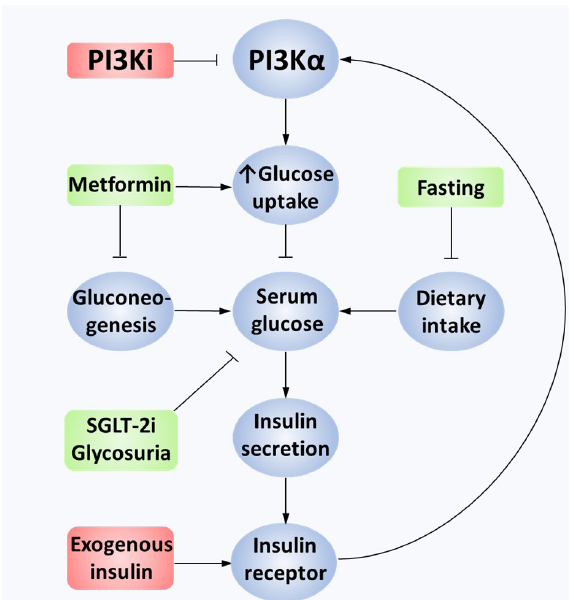
Figure 2. Mechanisms of hyperglycemia-mediated PI3K inhibitor resistance. Constitutively active PI3Kα leads to the transport of GLUT4 vesicles to the cell membrane, causing glucose uptake into cancer cells. PI3K inhibition limits downstream pathway activation in tumor and non-tumor cells. GLUT4 vesicles are no longer transferred to the cell membrane as an on-target negative consequence, leading to extracellular hyperglycemia. This stimulates excess insulin secretion in pancreatic beta cells, binding to IRs on cancer cells. Overactivation of the IR overcomes the PI3Ki effect, partially reactivating the PI3K/Akt/mTOR pathway. This effect can also be mediated by exogenous insulin. Minimizing hyperglycemia through fasting, metformin or SGLT-2 inhibition reduces insulin secretion, restoring the effectiveness of PI3K inhibition. GLUT4: glucose transporter type 4; PI3Ki: PI3K